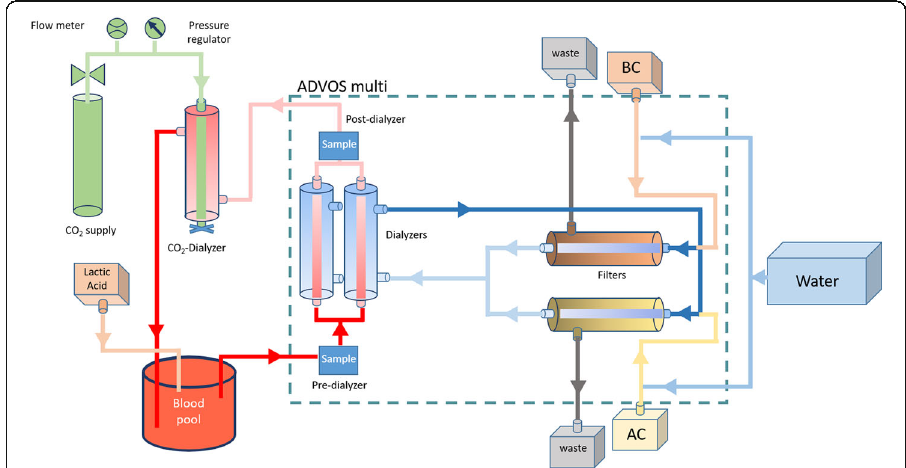
Fig. 1 Schematic representation of ADVOS multi device with a continuous CO 2 supply. Lactic acid was supplied in blood only for experimental settings 2 and 4 (see Table 1 for more